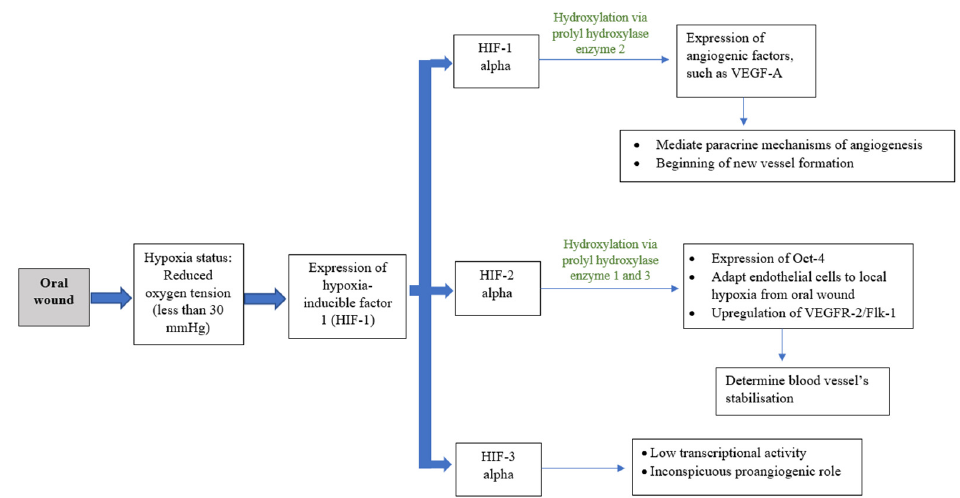
Figure 3. Schematic drawing showing co-relation of oxygenation and angiogenesis.